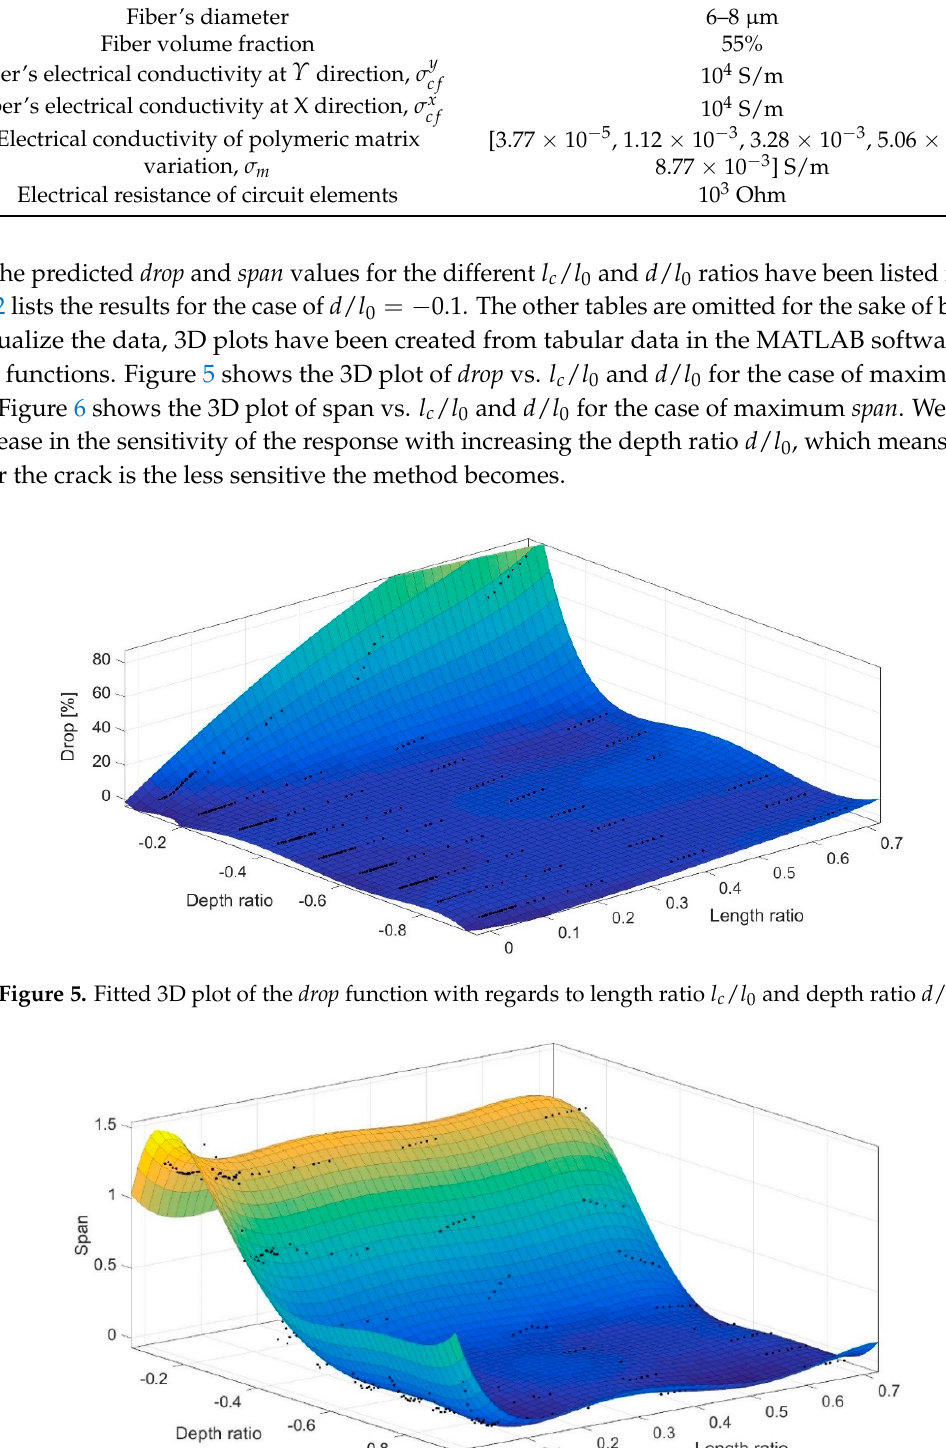
Figure 6. Fitted 3D plot of the span function with regards to length ratio l c / l 0 and depth ratio d / l 0 .